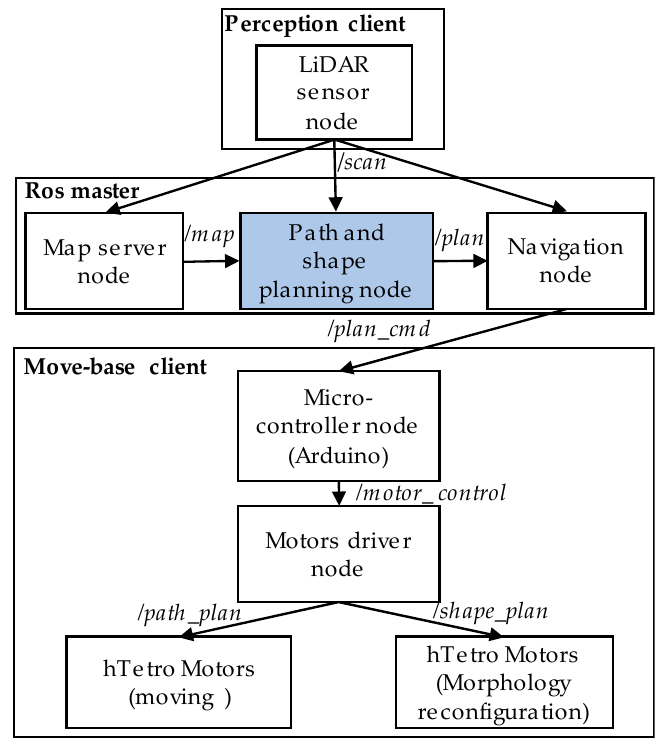
Figure 4. ROS based system of hTetro.